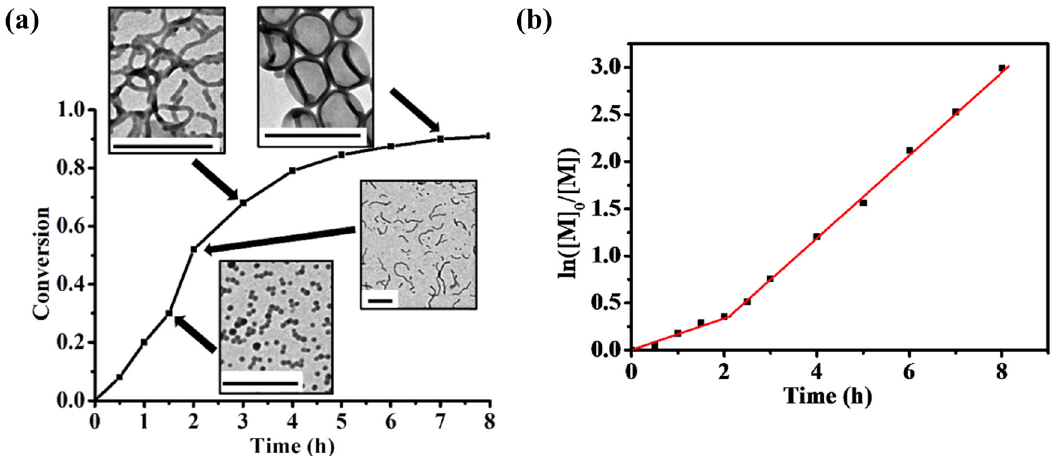
Figure 1: Dispersion polymerization kinetics for the target PDMA 43 - b - P ([ BVBIm ][ PF 6 ]) 60 at 25% w/v solid contents and 70°C: ( a ) monomer conversion vs polymerization time ( insets: TEM micrographs for the nano - objects observed at the indicated conversions; scale bar: 0.5 µm ) and ( b ) pseudo - fi rst - order kinetic plot.